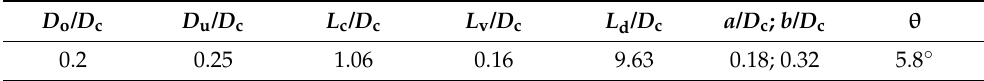
Figure 3. Fluid domain structure of hydrocyclone. Table 1. Structural parameters for oil–water separation